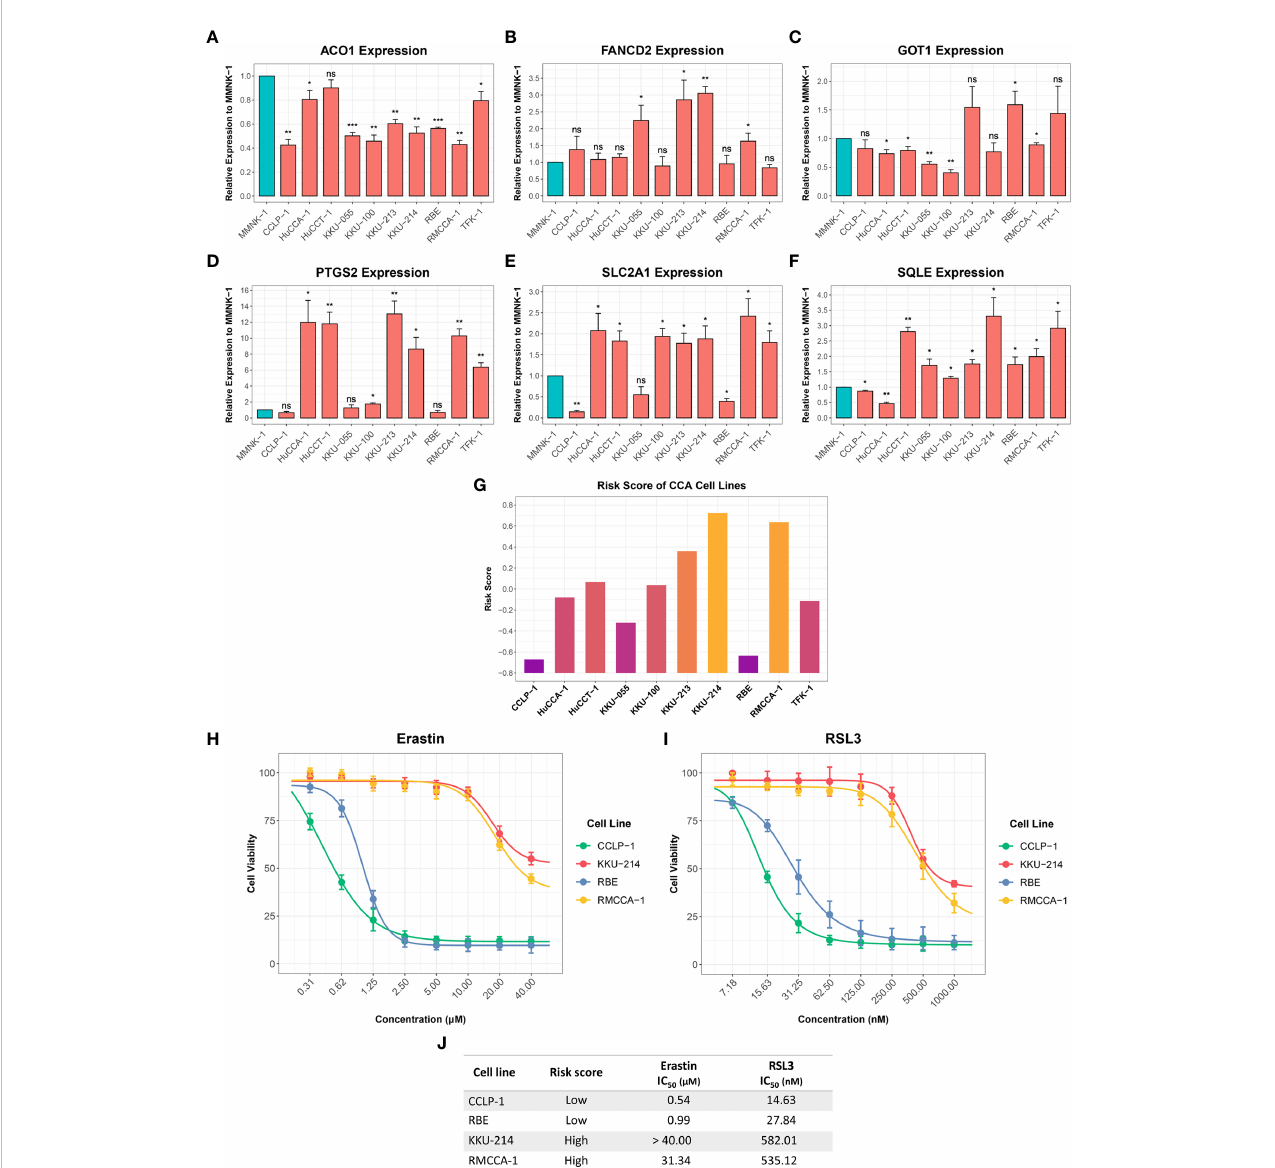
FIGURE 10 Expression of the six-FRG signature in CCA cell lines and their sensitivity to ferroptosis inducers. (A-F) The relative expression levels of the six-FRG signature in 10 CCA cell lines normalized to a non-tumor MMNK-1 cell line. (G) Risk scores calculated using six-FRG signature in 10 CCA cell lines. (H) Cell viability of CCLP-1, RBE, KKU-214, and RMCCA-1 treated with erastin. (I) Cell viability of CCLP-1, RBE, KKU-214, and RMCCA-1 treated with RSL3. (J) A table showing IC 50 of erastin and RSL3 in CCLP-1, RBE, KKU-214, and RMCCA-1. Key: ns, not signi fi cant; * p < 0.05; ** p < 0.01; *** p <